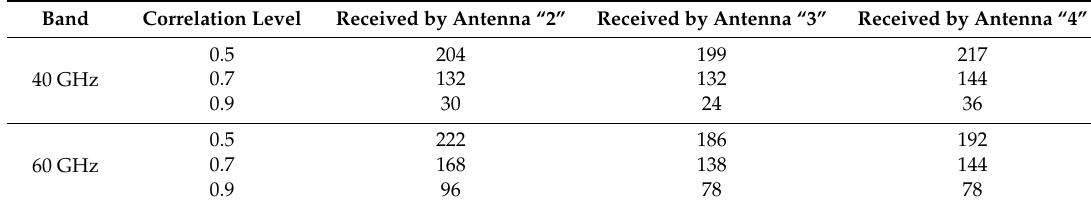
Table 2. The 99th percentile of coherence bandwidth (MHz), in the auditorium.